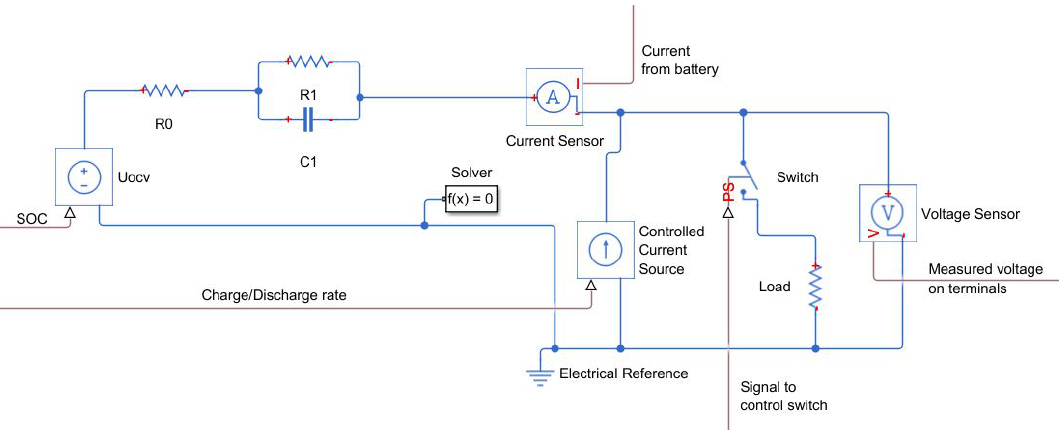
Figure 5. Proposed model